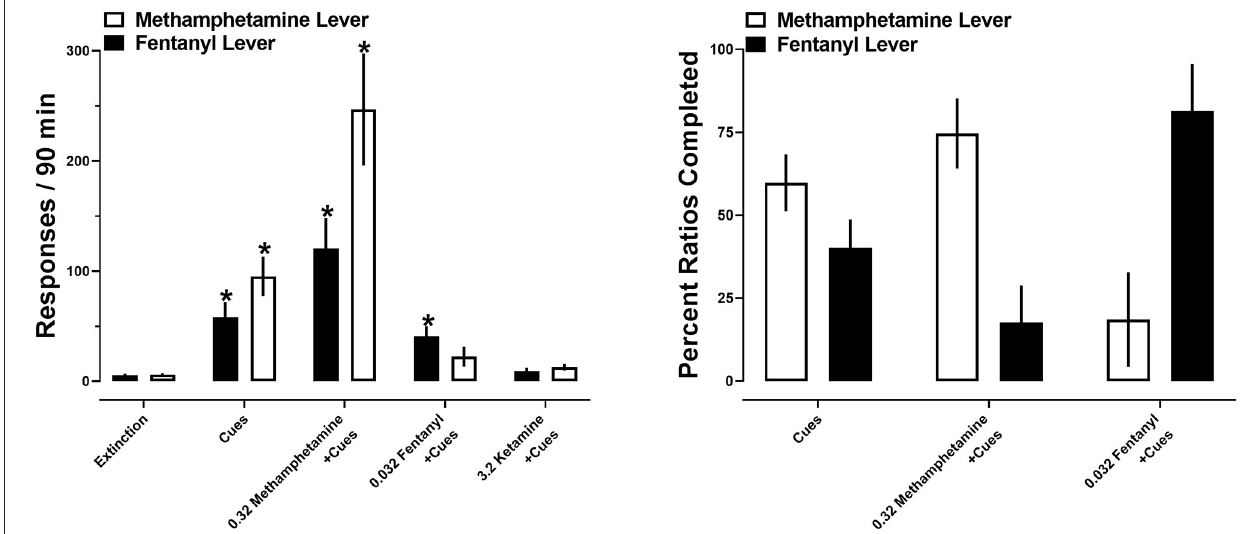
FIGURE 6 | (Left) Responses made on the methamphetamine (open bars) and fentanyl (closed bars) levers on the final day of extinction and during reinstatement tests. Asterisks represent a significant increase from extinction ( p < 0.05). Each bar represents 12 rats. (Right) percent of the first 10 ratios completed on the methamphetamine (open bars) and fentanyl (closed bars) levers during reinstatement tests. Each set of bars represents 8–12 rats. All data represent the mean ± S.E.M.